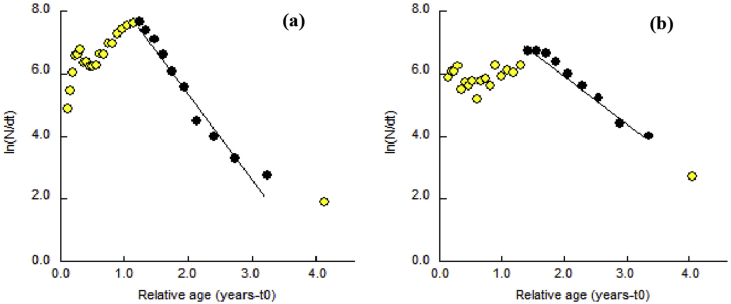
Length converted catch curves for (a) male and (b) female S. olivacea of Sundarban Mangrove of Bangladesh (The filled dots represent the points used in calculating through least square liner regression and the open dots represent the point either not fully recruited).